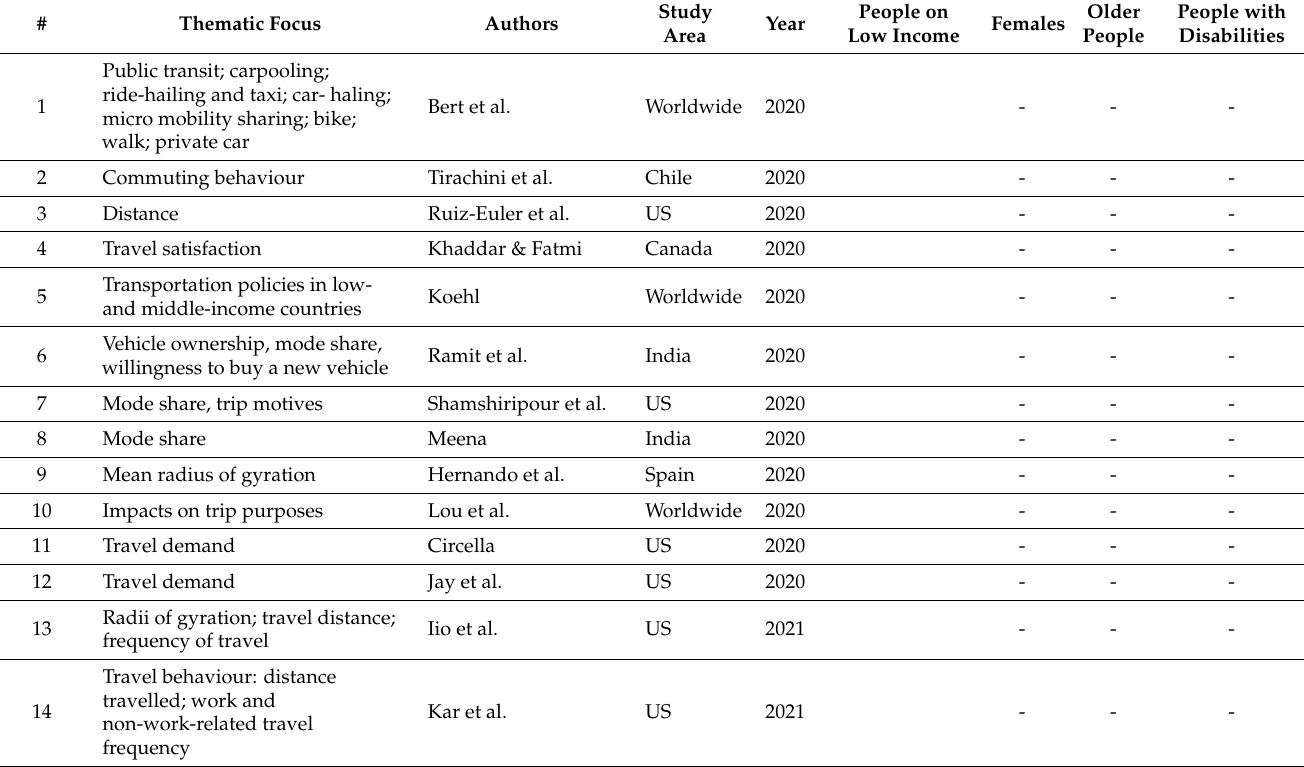
Table A1. The profile of the studies selected for the literature